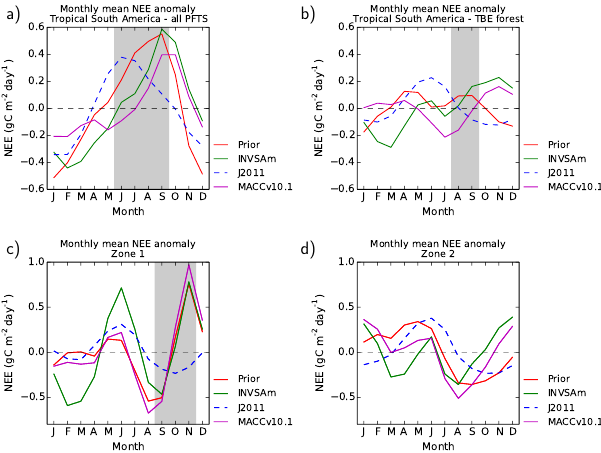
Figure 7. Monthly mean NEE anomaly integrated over (a) the TSA region and (b) over pixels dominated by TBE forests in ORCHIDEE for 2002–2010. The shaded areas denote dry seasons, defined as months with precipitation < 100mm, based on monthly totals from TRMM data over 2002–2010. Estimates from prior fluxes (red), IN- VSAm (green), CH2010 (purple) and J2011 (dashed blue). (c–d) Monthly mean NEE integrated over the zones 1 (c) and 2 (d) that are defined in Fig.